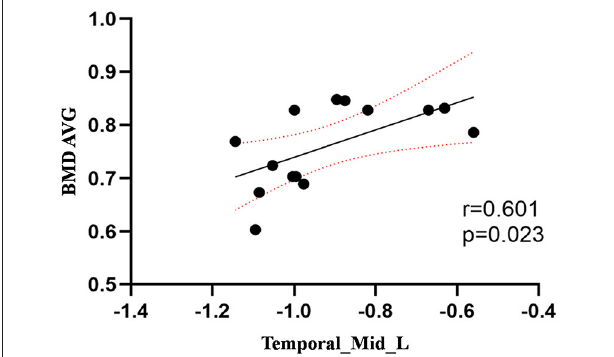
FIGURE 2 | Correlation between ReHo values of the left MTG and the BMD AVG. The ReHo values of the left MTG showed a positive correlation with the BMD AVG ( r = 0.601; P = 0.023).